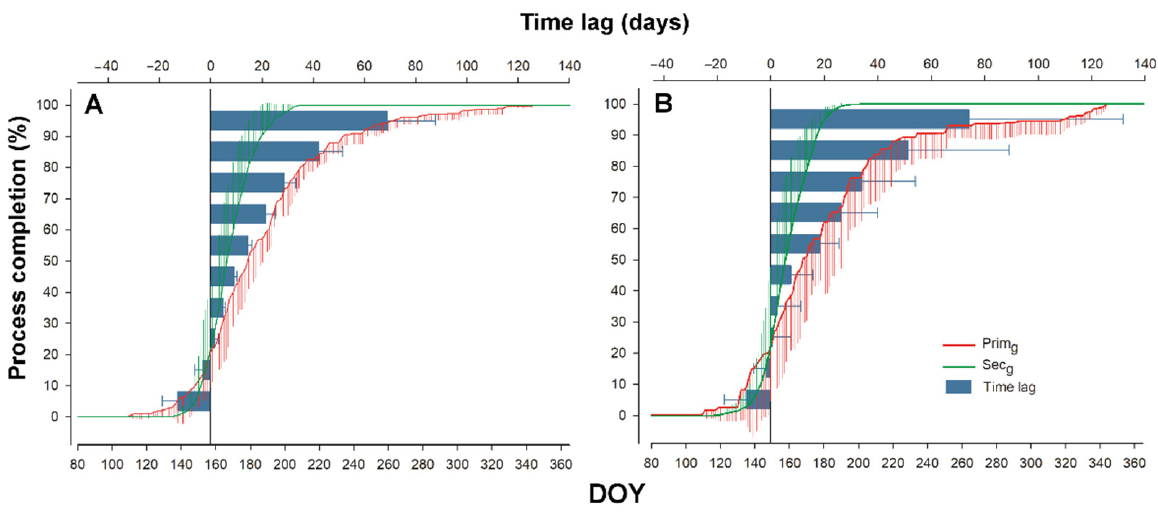
Figure 8. Timing and time lag of primary (P growth ) and secondary growth (S growth ) at the ESP Bily Kriz ( A ) and Rajec ( B ) in 2016–2019. Time lag between seasonal dynamics of primary growth and secondary growth, both processes are expressed in relative values (percentage of completion).